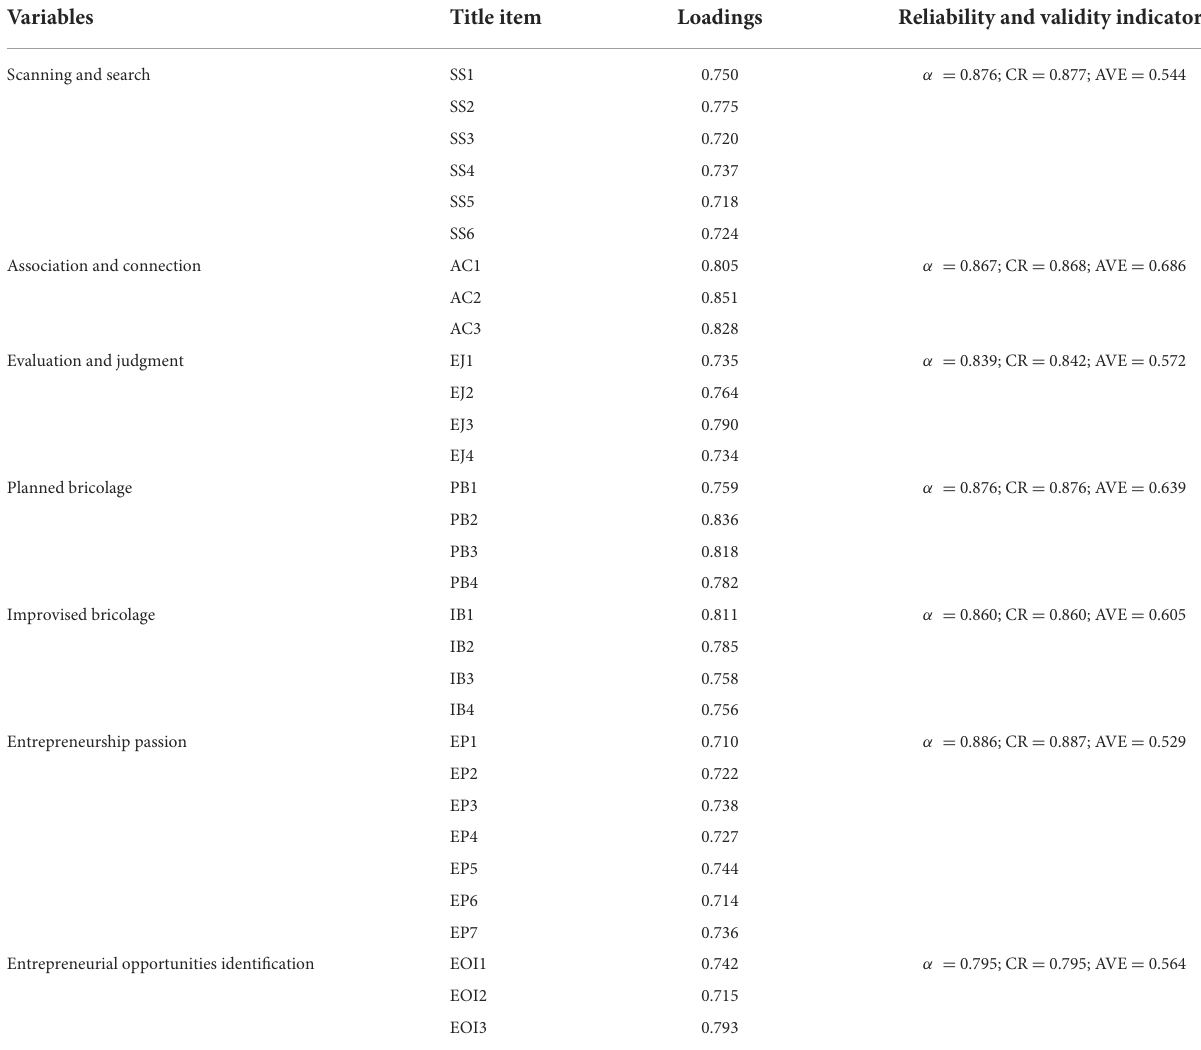
TABLE 2 Reliability and validity